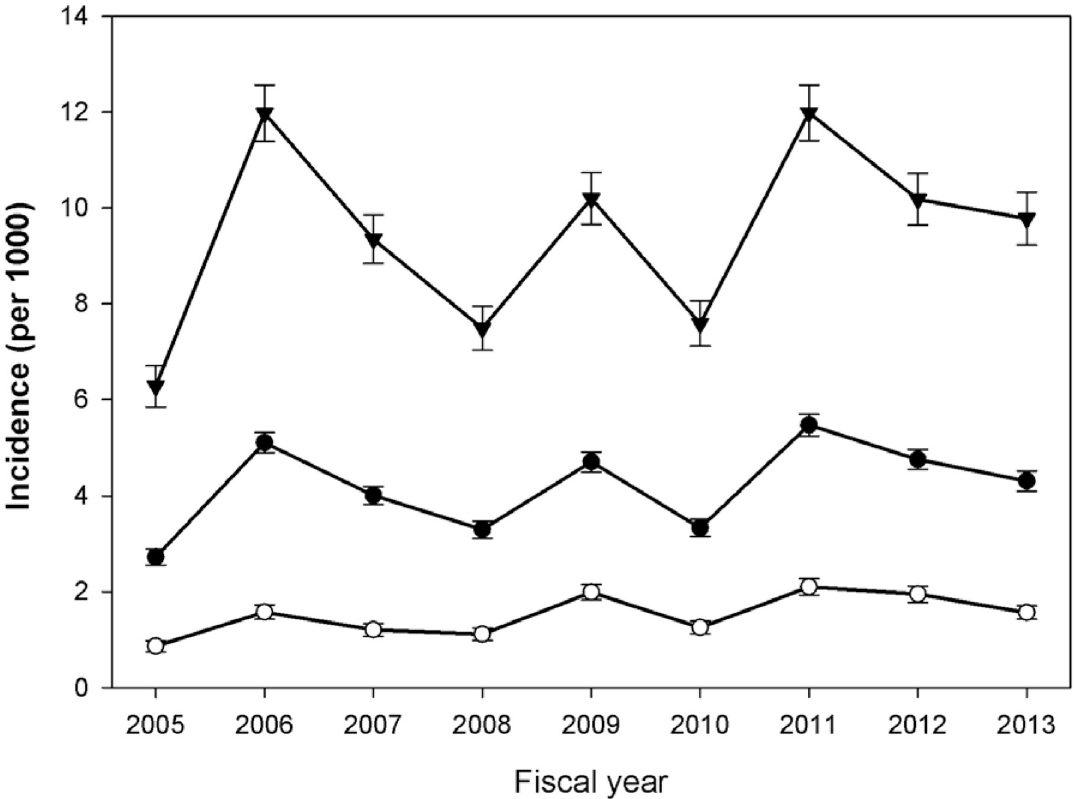
Fig 2. Incidence of hospitalized RSV (per 1000 children) 2005 – 2013 with 95% confidence intervals. Legend: Incidence per 1000 person years is given for each fiscal year from 2005 to 2013. Error bars shown are the calculated 95% confidence intervals. Closed circles ( (cid:129) ) represent the incidence in the full Ontario cohort of children under 3 years of age. Closed triangles ( ! ) represent the incidence for children under 1 year of age. Open circles ( ο ) represent the incidence for children between 1 and 3 years of